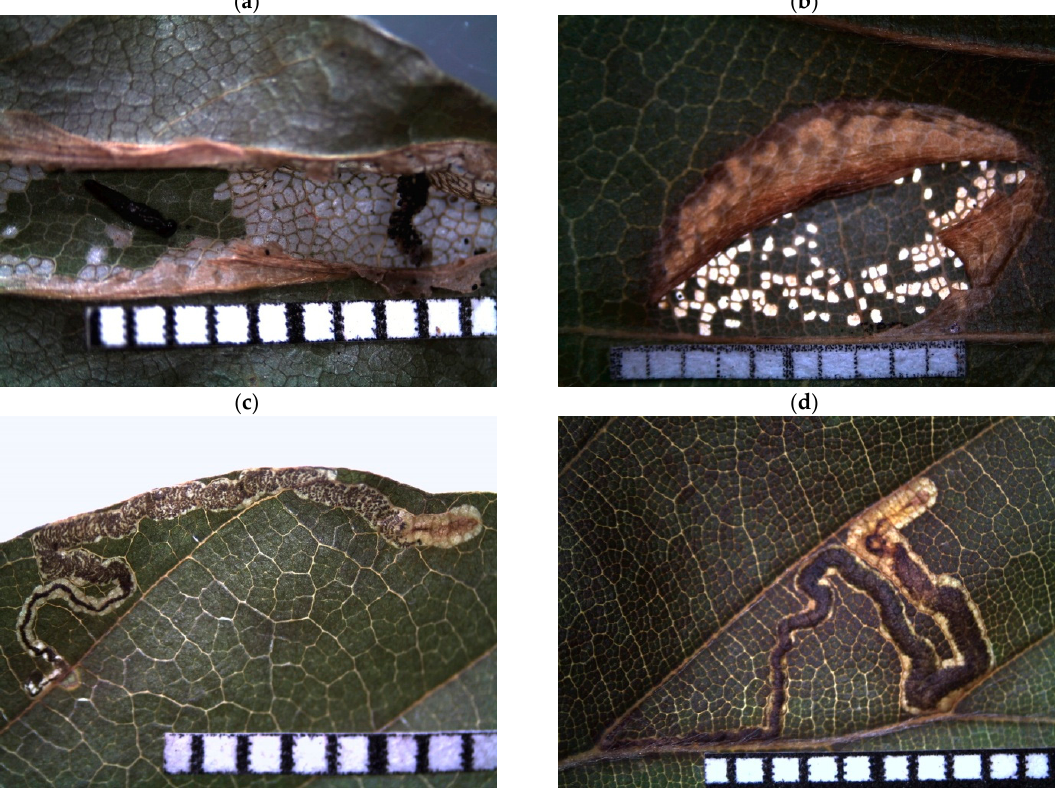
Figure A2. Feeding traces (Recognizable Taxonomic Units) of miners (endophagous feeding guild) on Fagus sylvatica leaves. ( a ) Tubular mine (probably Phyllonorycter maestingella , ABS); ( b ) oval mine (probably Phyllonorycter messaniella , ABS); ( c ) line crossing lateral veins (probably Stigmella hemargyrella , ADS); ( d ) line between lateral veins ( probably Stigmella tityrella , ADS). Images were taken with an integrated digital camera of a stereo microscope (LEICA EZ4 D, Wetzlar, Germany). Little square equals 1×1 mm, ADS = adaxial side, ABS = abaxial side.